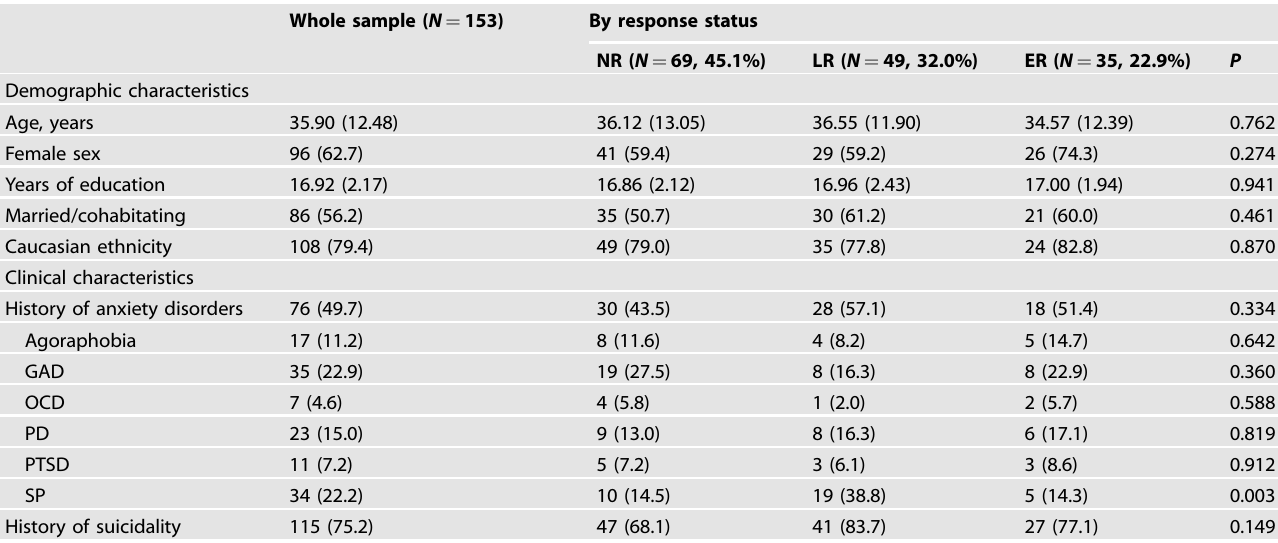
Table 1. Demographic and clinical characteristics of the